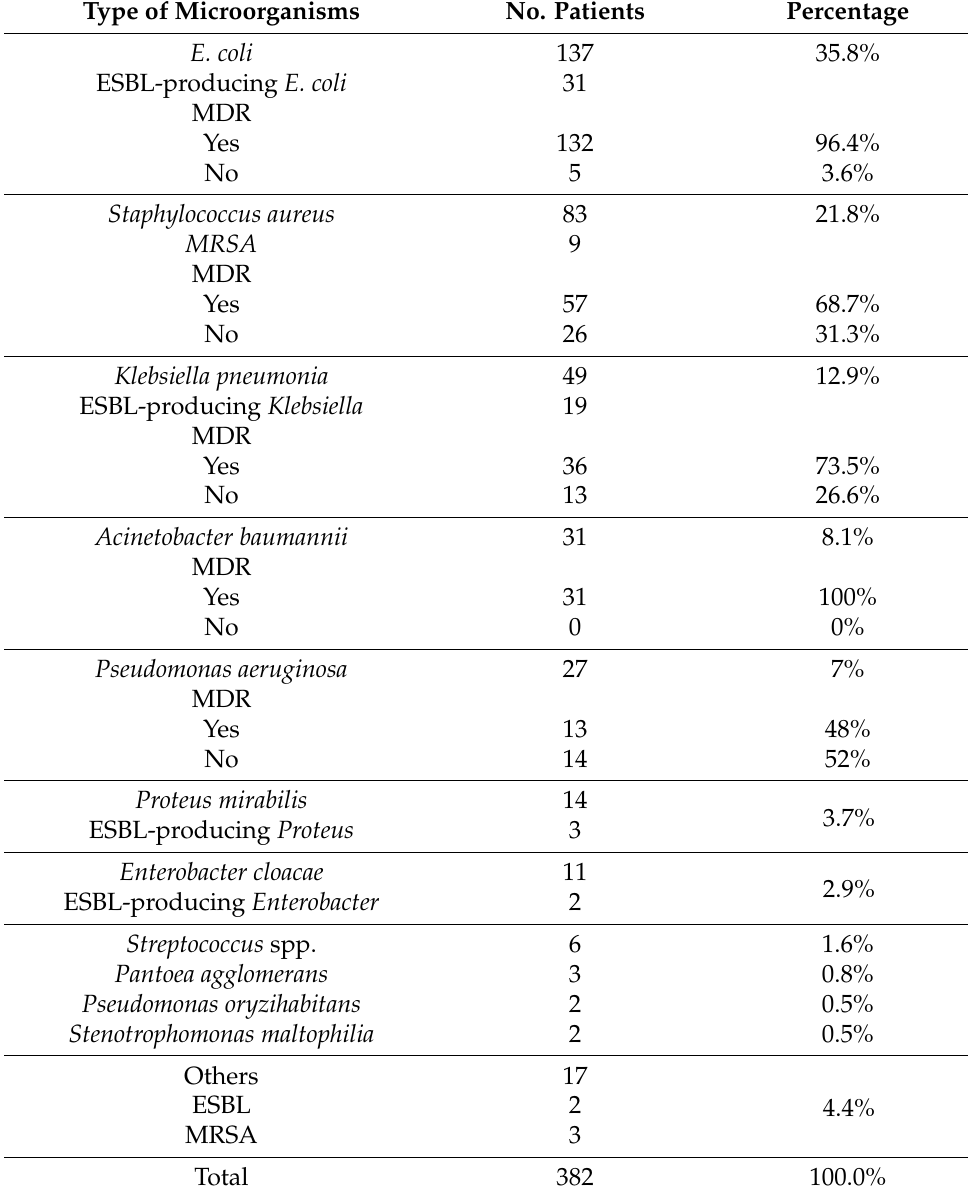
Table 2. Most common